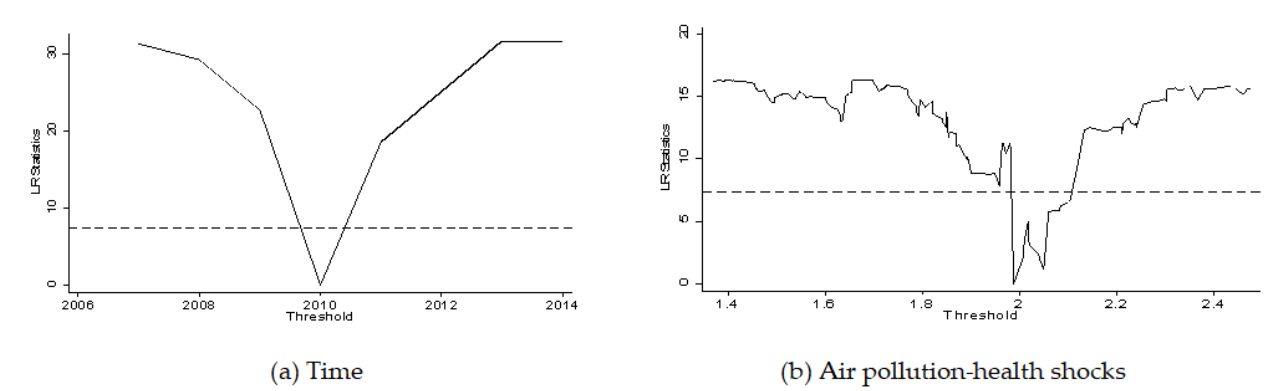
Figure 8. The LR statistics value trend estimated for the threshold variable.